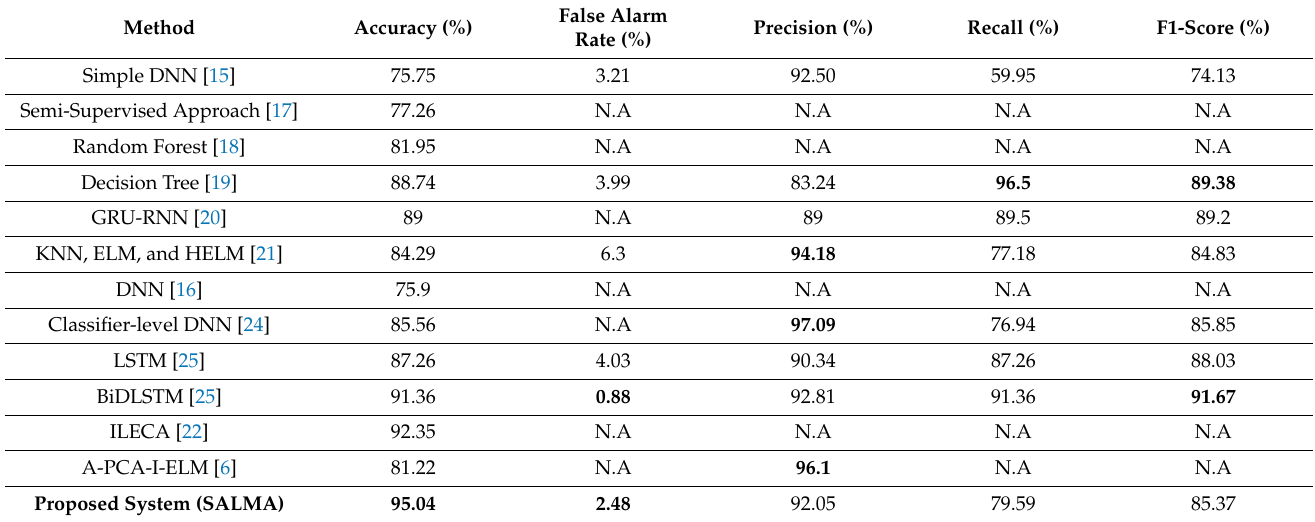
Table 7. Comparison between the proposed system and previous approaches to the NSL-KDD